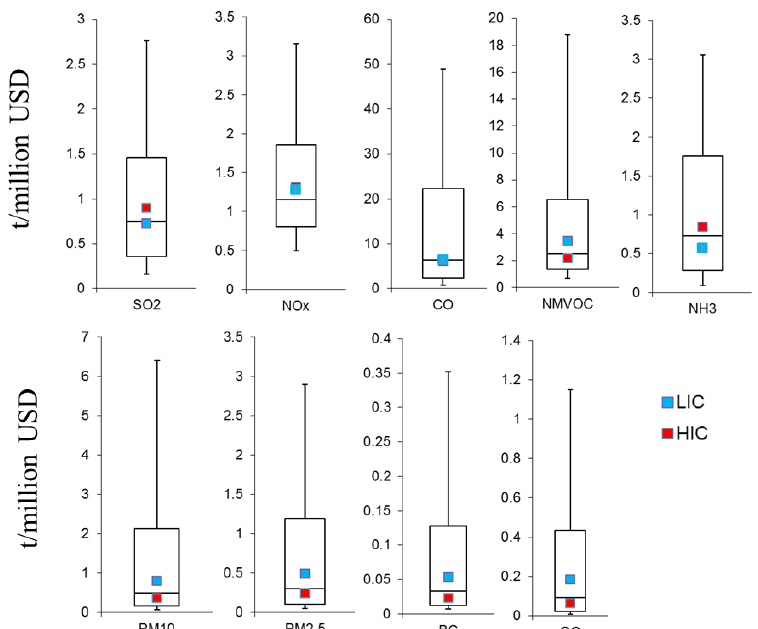
Figure 9. Pollutant-specific emissions divided by GDP (tmillionUSD − 1 ) for the year 2010. Percentiles of emissions per GDP are reported in the box plots (10th, 25th, 50th, 75th, and 90th percentile), while the median of low-income and high-income countries is represented with light blue and red makers,